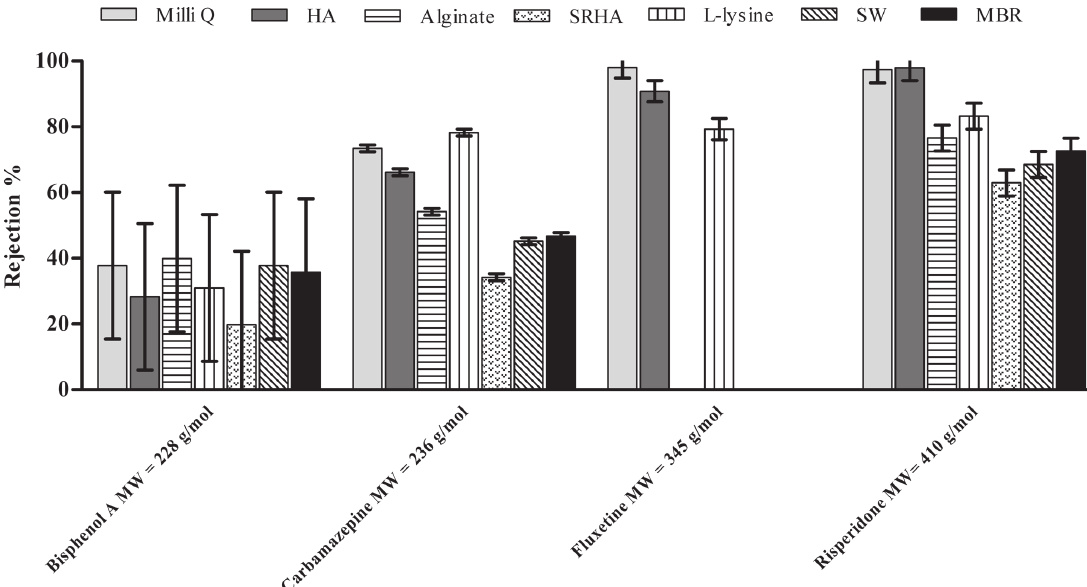
Figure 6. Rejection of hydrophobic nonionic compounds by di ff erent fouled membranes.